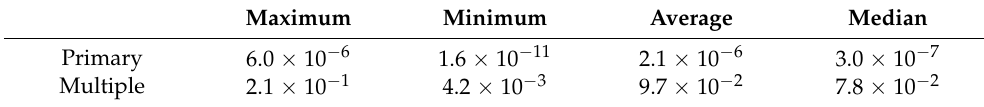
Table 1. Local similarity statistics between primaries and